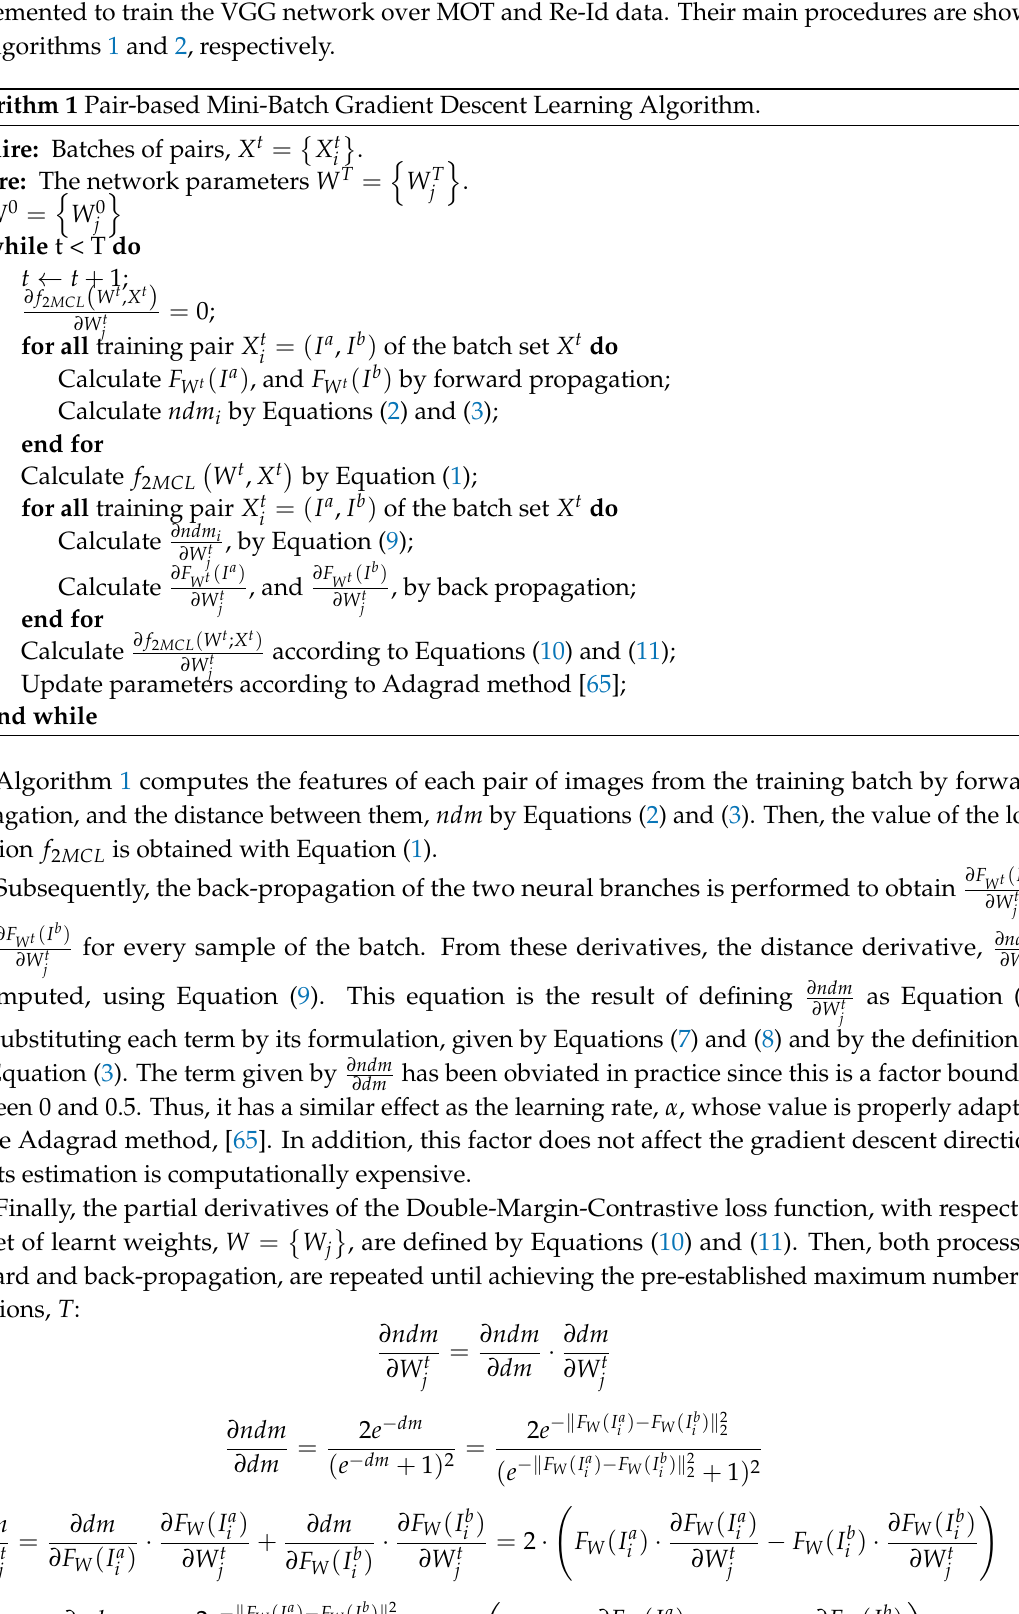
Algorithm 1 Pair-based Mini-Batch Gradient Descent Learning Algorithm.